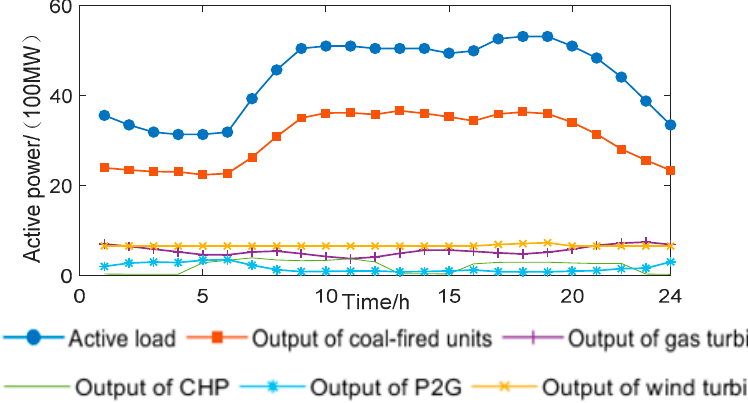
Figure 4. Power network optimized operation data.